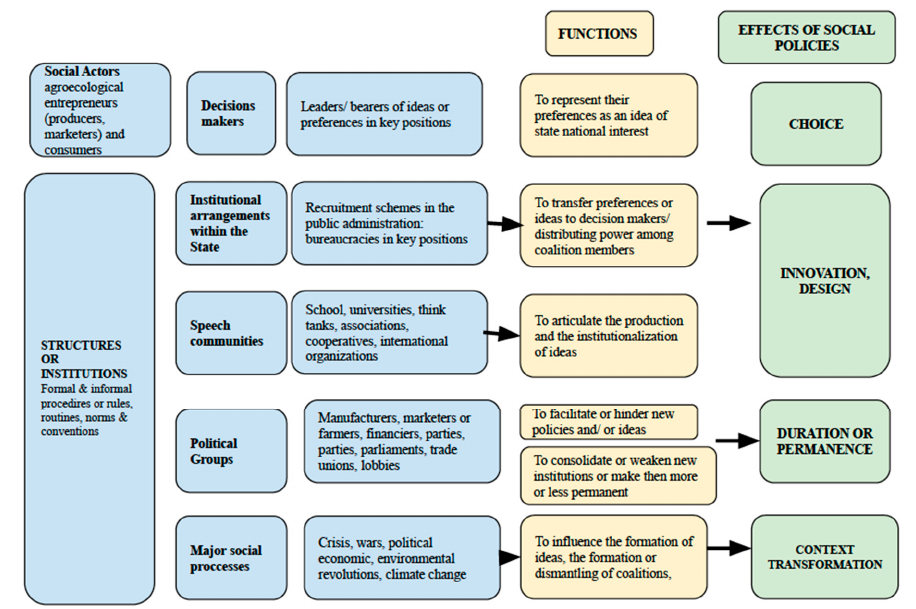
Figure 5. Conceptual model of new institutionalism and public policies. Source: The authors, adapted from [16].